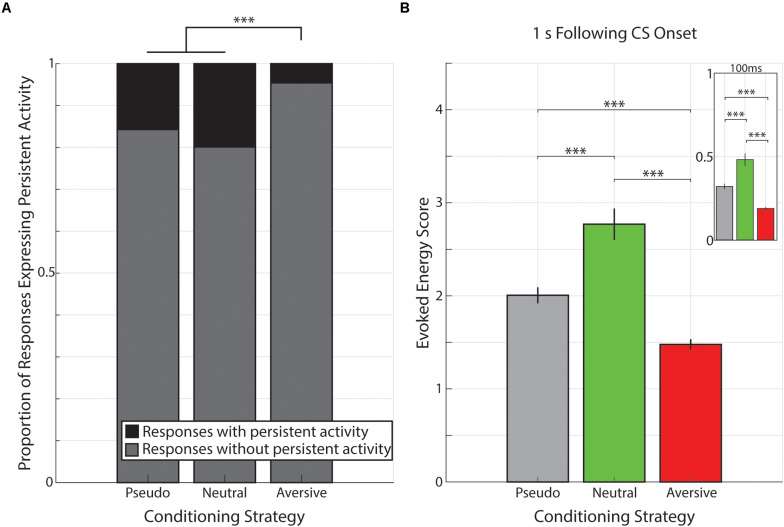
Proportion of responses with persistent activity is smaller following aversive conditioning. (A) Bar graph showing proportions of responses classified as expressing persistent activity (black) or not (gray) during pseudo-conditioning (left), neutral conditioning (middle), or aversive conditioning (right). ∗∗∗p < 1 × 10− 6, χ2 goodness-of-fit test. (B) Bar graph demonstrating that the evoked energy of cue-evoked responses is significantly greater in animals underwent neutral conditioning and evoked energy is significantly smaller in animals that underwent aversive conditioning. Main graph shows the evoked energy calculated in the 1 s following visual stimulation and inset shows evoked energy calculated in the 100 ms of visual stimulation. Vertical bars represent mean +SEM. ∗∗∗p < 0.001, Tukey’s HSD post hoc test following Kruskal–Wallis Test.